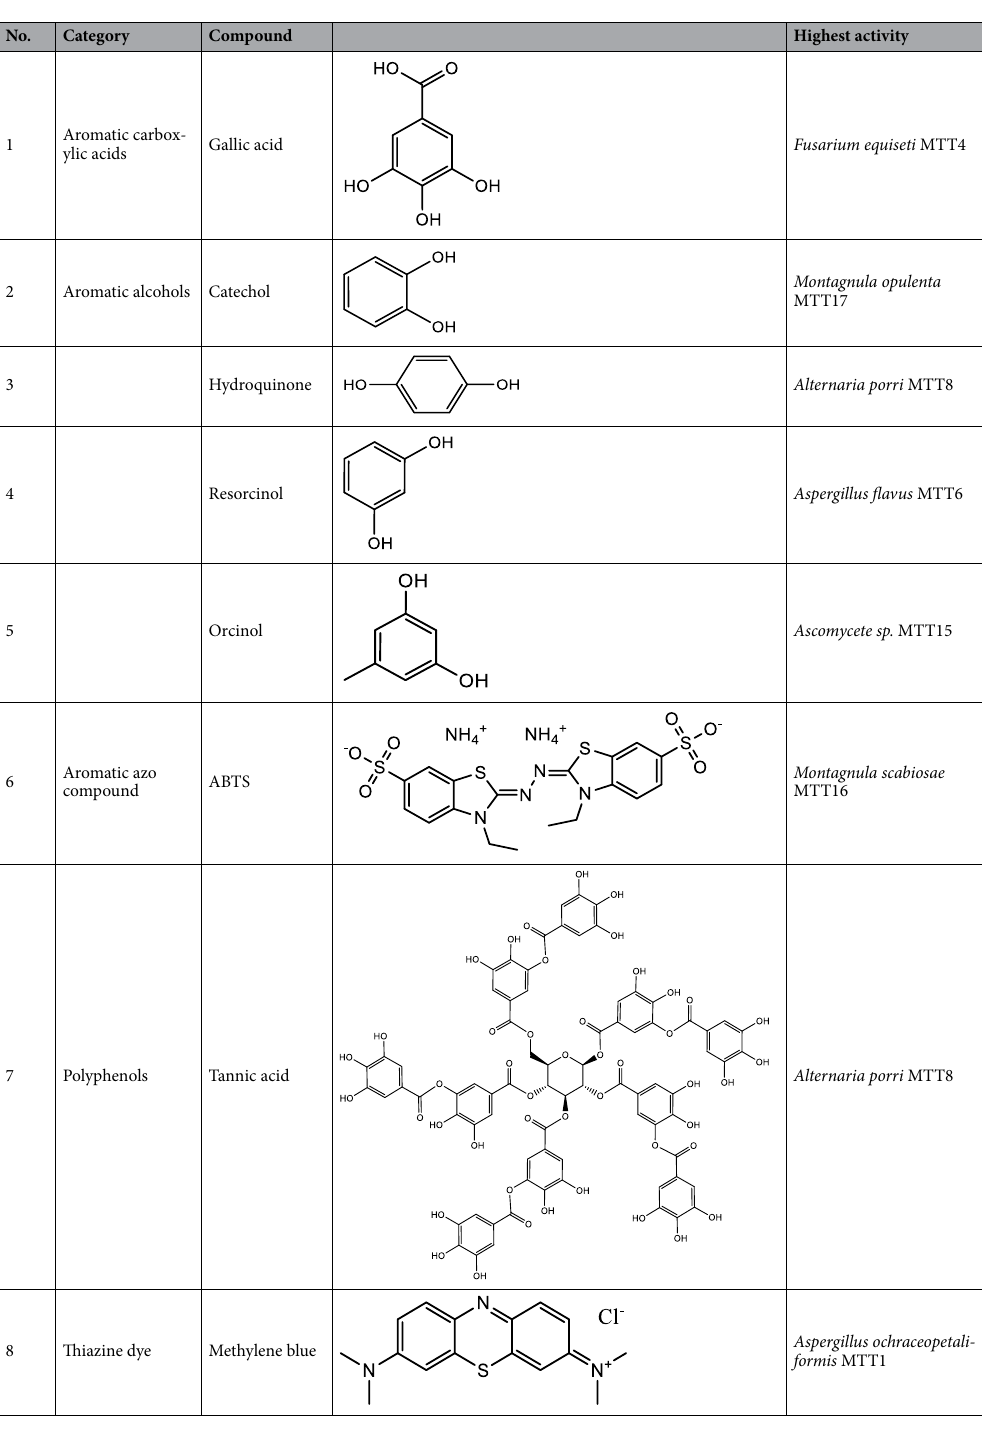
Table 4. Fungal isolates with the highest extracellular oxidoreductase activity for each of the 8 tested substrates (ChemBioDraw v12.0, level: